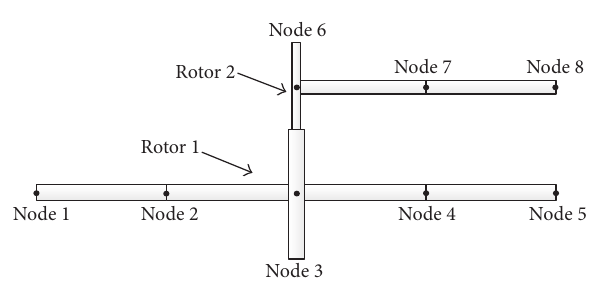
Figure 3: Rotors coupled by a gear.